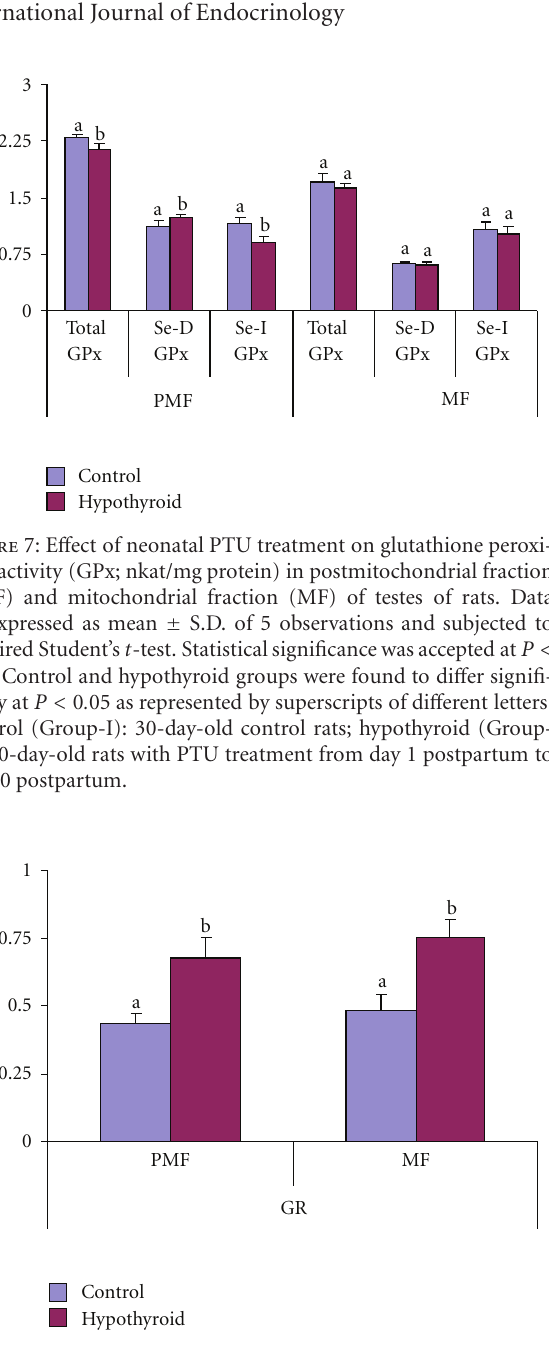
Figure 8: E ff ect of neonatal PTU treatment on glutathione reduc- tase activity (GR; nkat/mg protein) in postmitochondrial fraction (PMF) and mitochondrial fraction (MF) of testes of rats. Data are expressed as mean ± S.D. of 5 observations and subjected to unpaired Student’s t -test. Statistical significance was accepted at P < 0 . 05. Control and hypothyroid groups were found to di ff er significantly at P < 0 . 05 as represented by superscripts of di ff erent